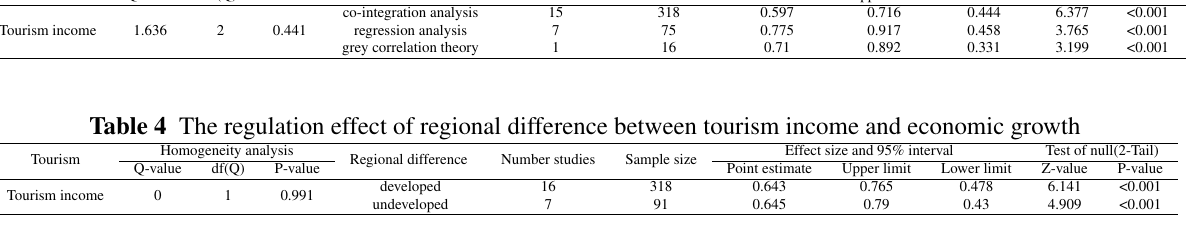
Table 3 The regulation effect of analytical method between tourism income and economic growth Tourism